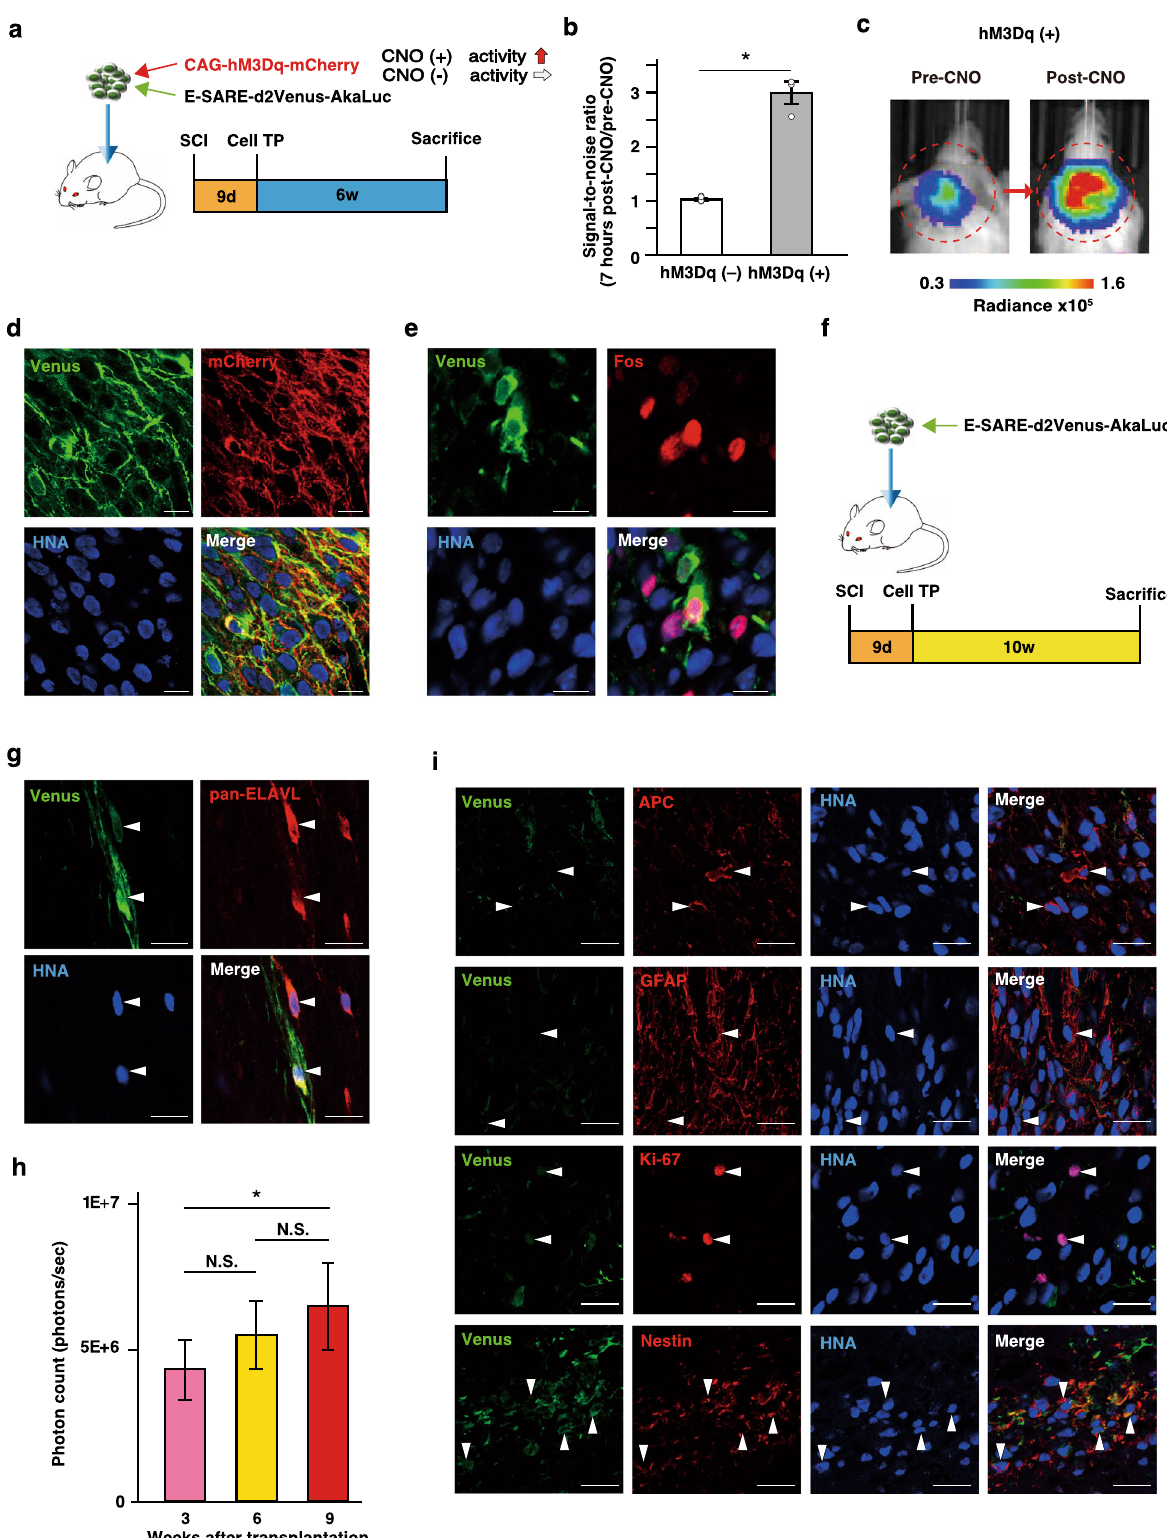
elucidation of how neural grafts functionally integrate into host circuits and how graft activity contributes to behavioural recov- ery. Our ESAL system can monitor graft activity in the context of various host behaviours, leading to elucidation of the mechanism of neuronal relay formation and its contribution to functional recovery.